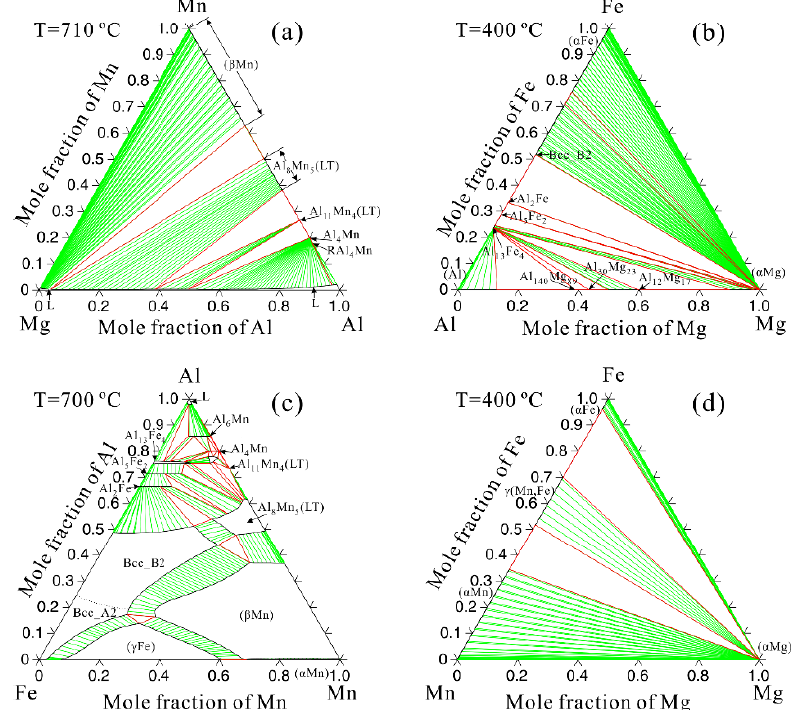
Figure 3. Calculated isothermal sections of four ternary systems based on the self-constructed Mg-Al-Mn-Fe database: ( a ) Al-Mg-Mn at 710 °C, ( b ) Mg-Al-Fe at 400 °C, ( c ) Al-Fe-Mn at 700 °C, ( d ) Fe-Mg-Mn at 400 °C. The dashed line in ( c ) represents the calculated Bcc_A2/Bcc_B2 transition line.